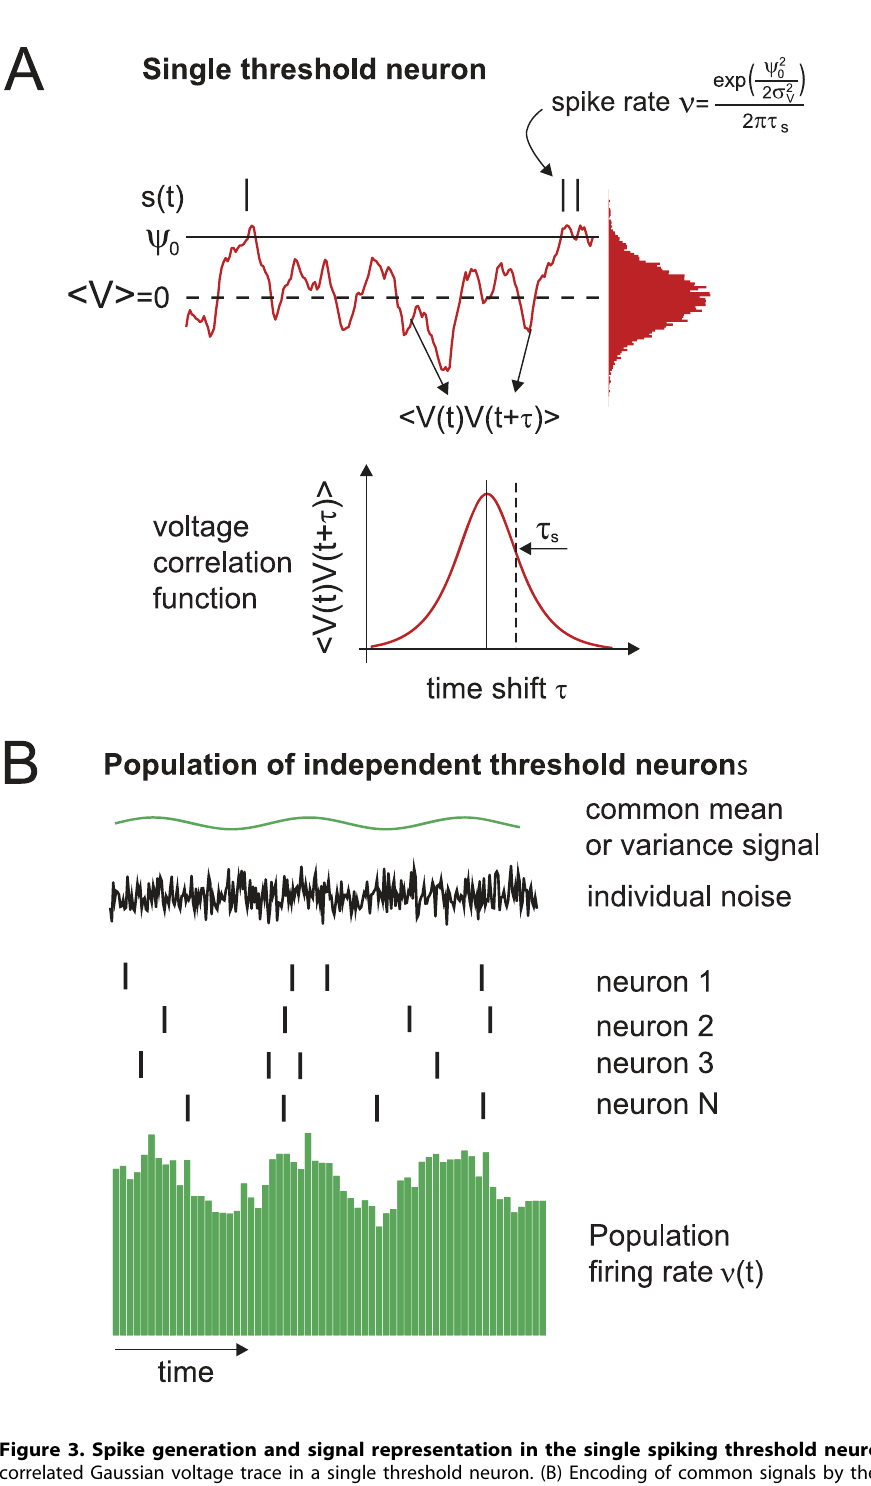
PLoS Computational Biology |